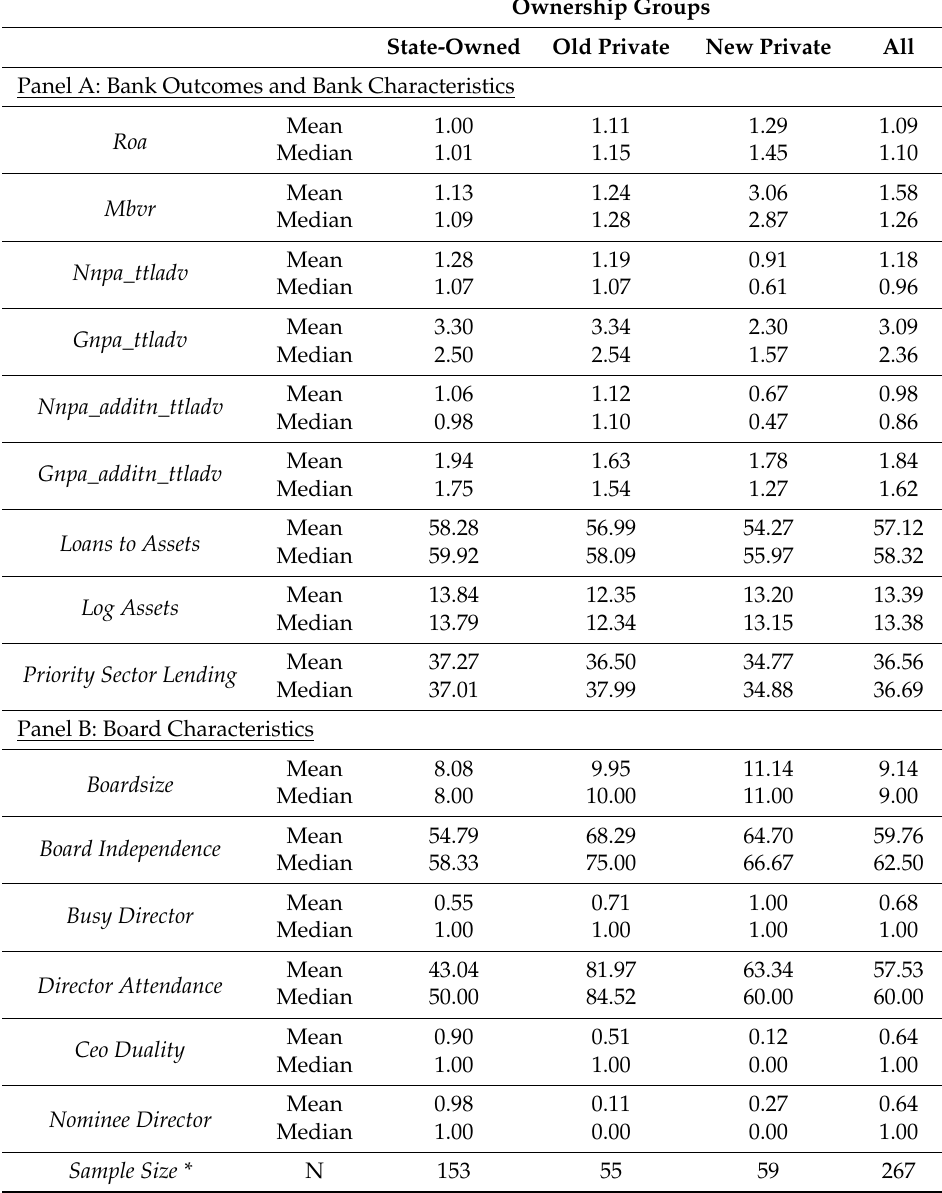
Table 2. Summary Statistics of Bank Performance Measures and Bank